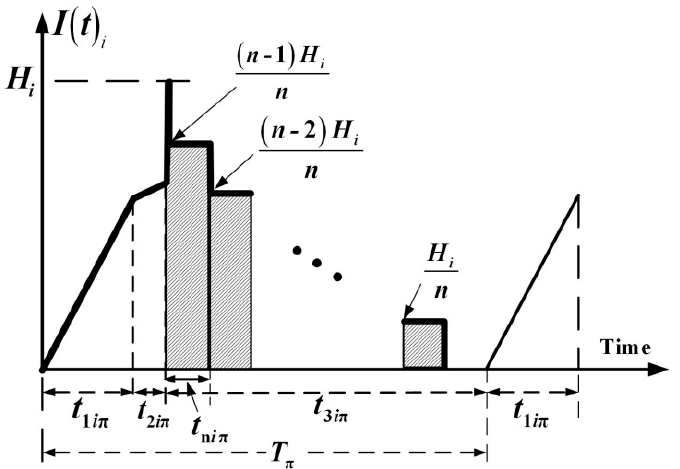
Figure 4. Inventory status in t 3 i π at the manufacturer side.